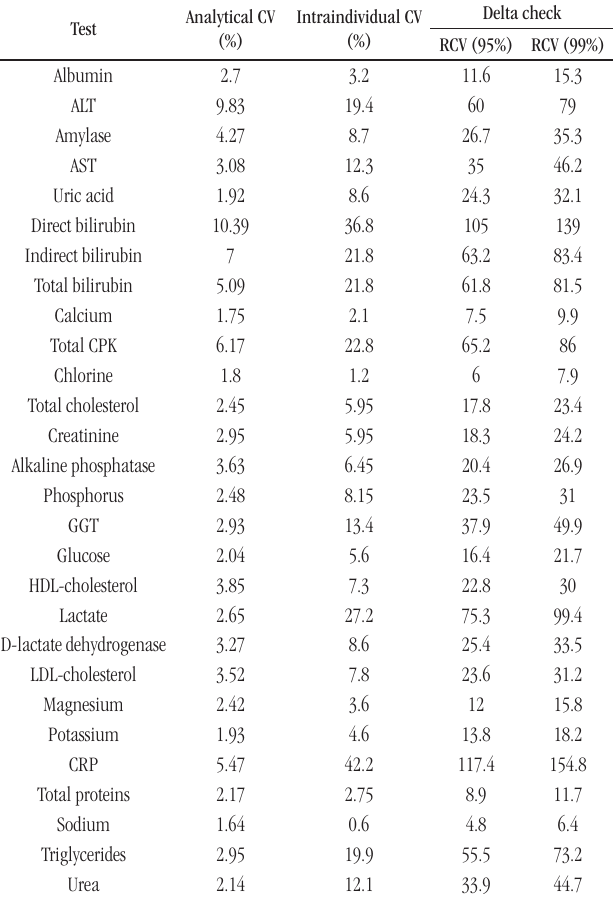
taBLE 1 − Values of delta check adopted for autoverification at the core laboratory of